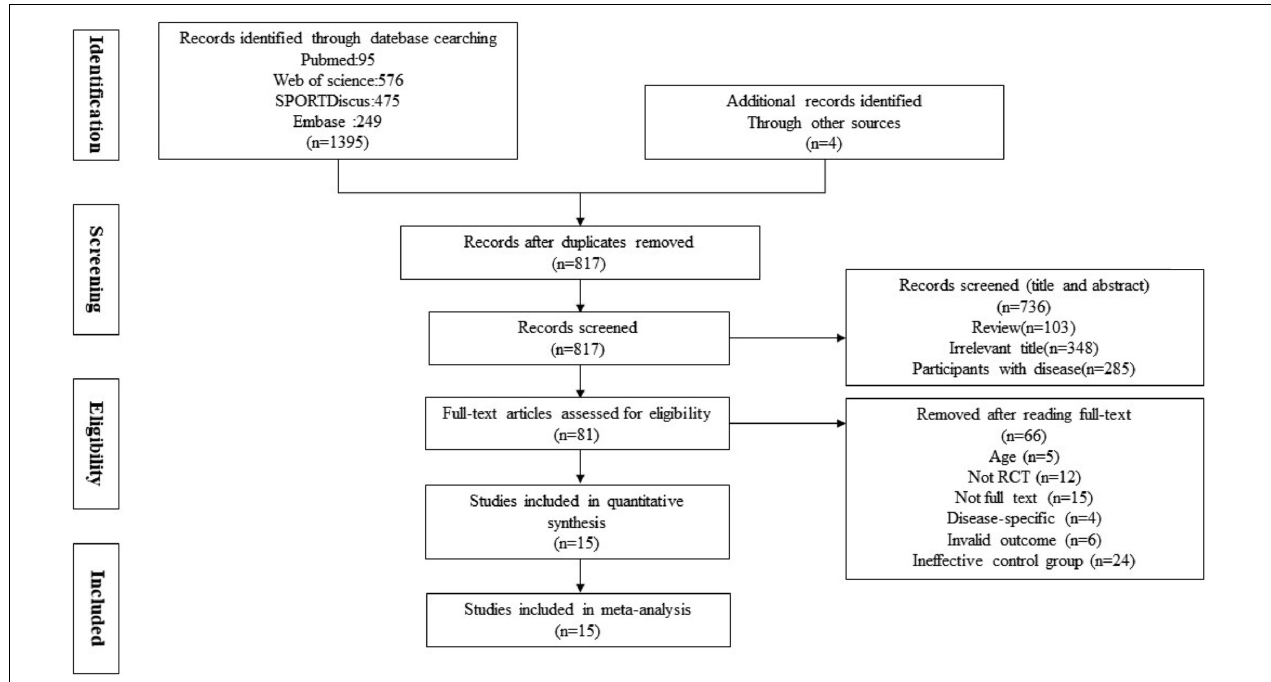
FIGURE 1 | Preferred reporting items for systematic reviews and meta-analyses (PRISMA) flow chart of the study identification and selection